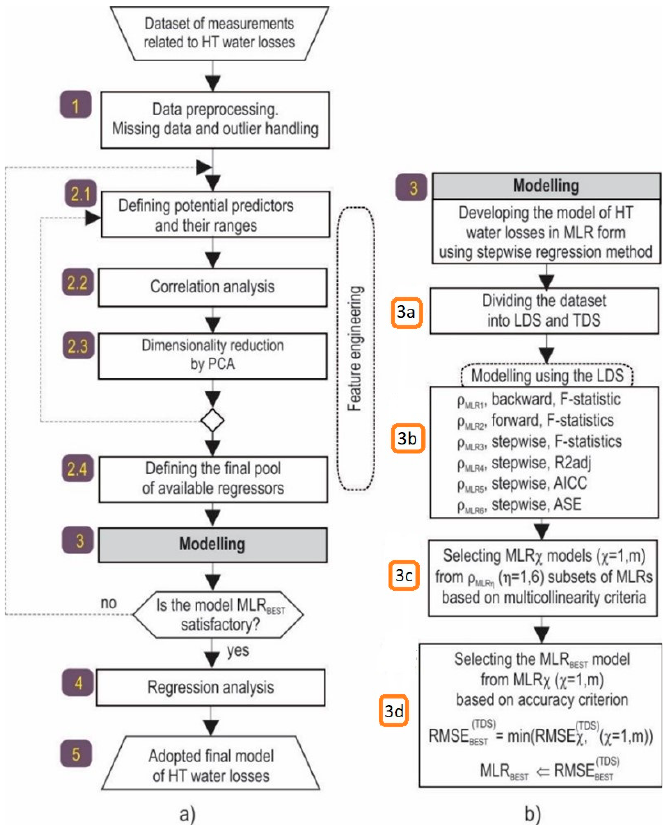
Figure 1. Developed methodology for modeling of total water losses in hydraulic tunnels: ( a ) Schematic overview; and ( b ) stepwise regression modeling method.